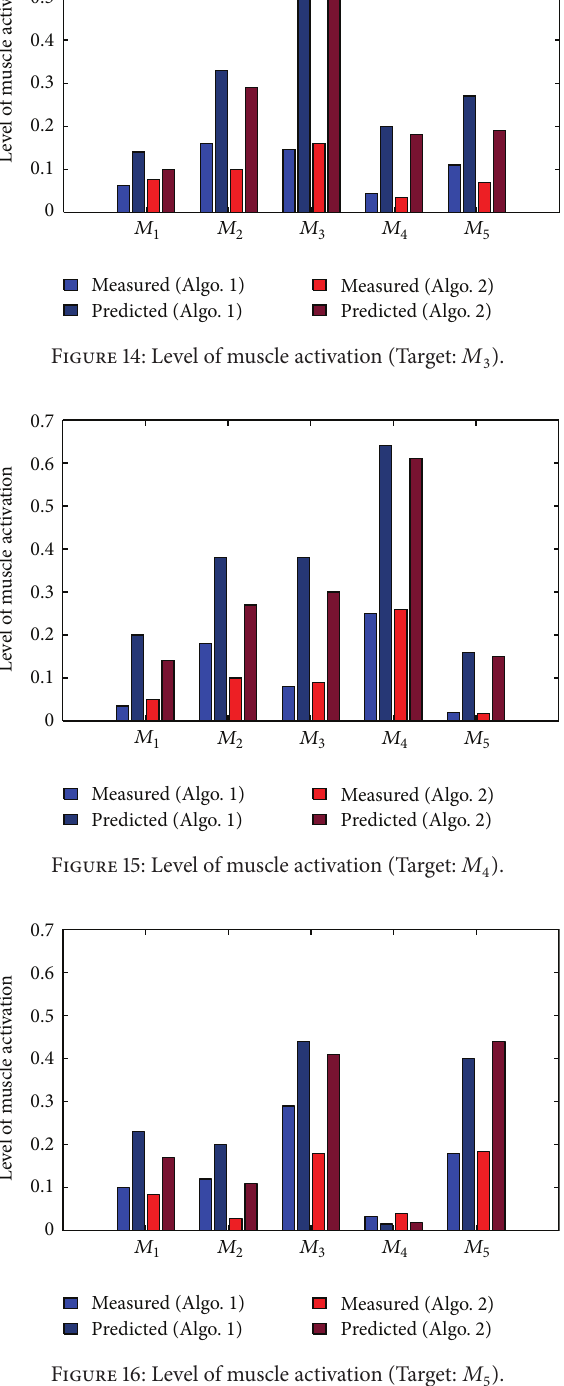
Figure 16: Level of muscle activation (Target: 𝑀 5